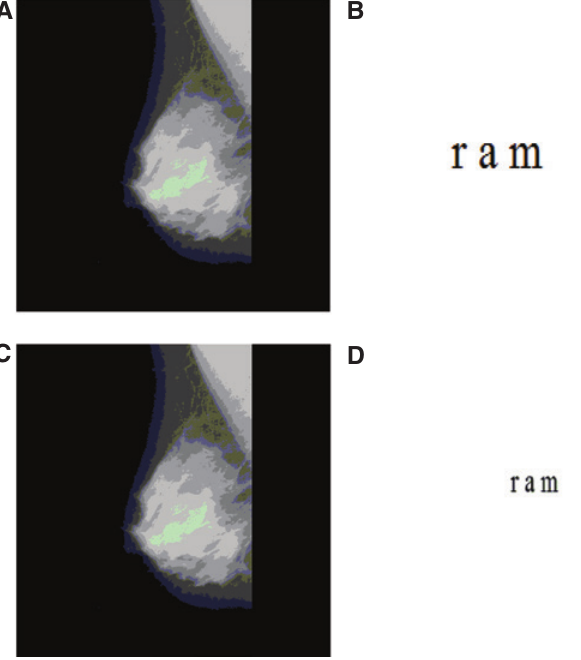
Figure 5: Intermediate Results of Image